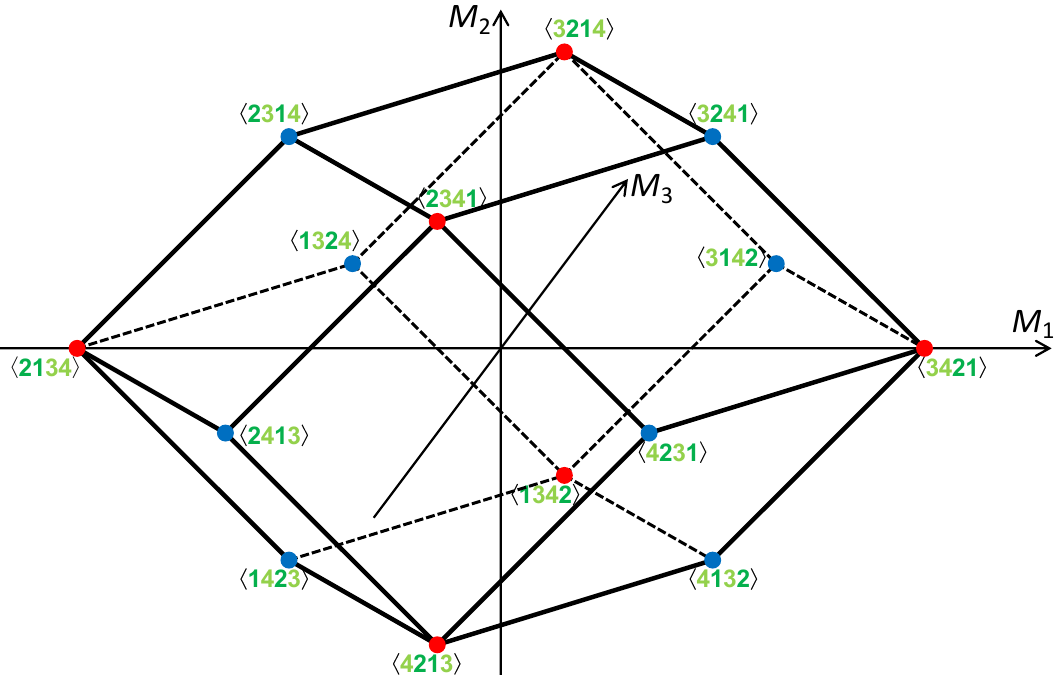
Figure 2 . The fundamental domain of duality cascades for brane configurations with two NS5- branes and two (1 , k ) 5-branes. The brane configurations without rank differences appear as vertices and we label the vertices by the brane configurations h· · · i with • and ◦ omitted by denoting the labels in dark and light green. Interestingly, the fundamental domain is the famous rhombic dodecahedron studied by Johannes